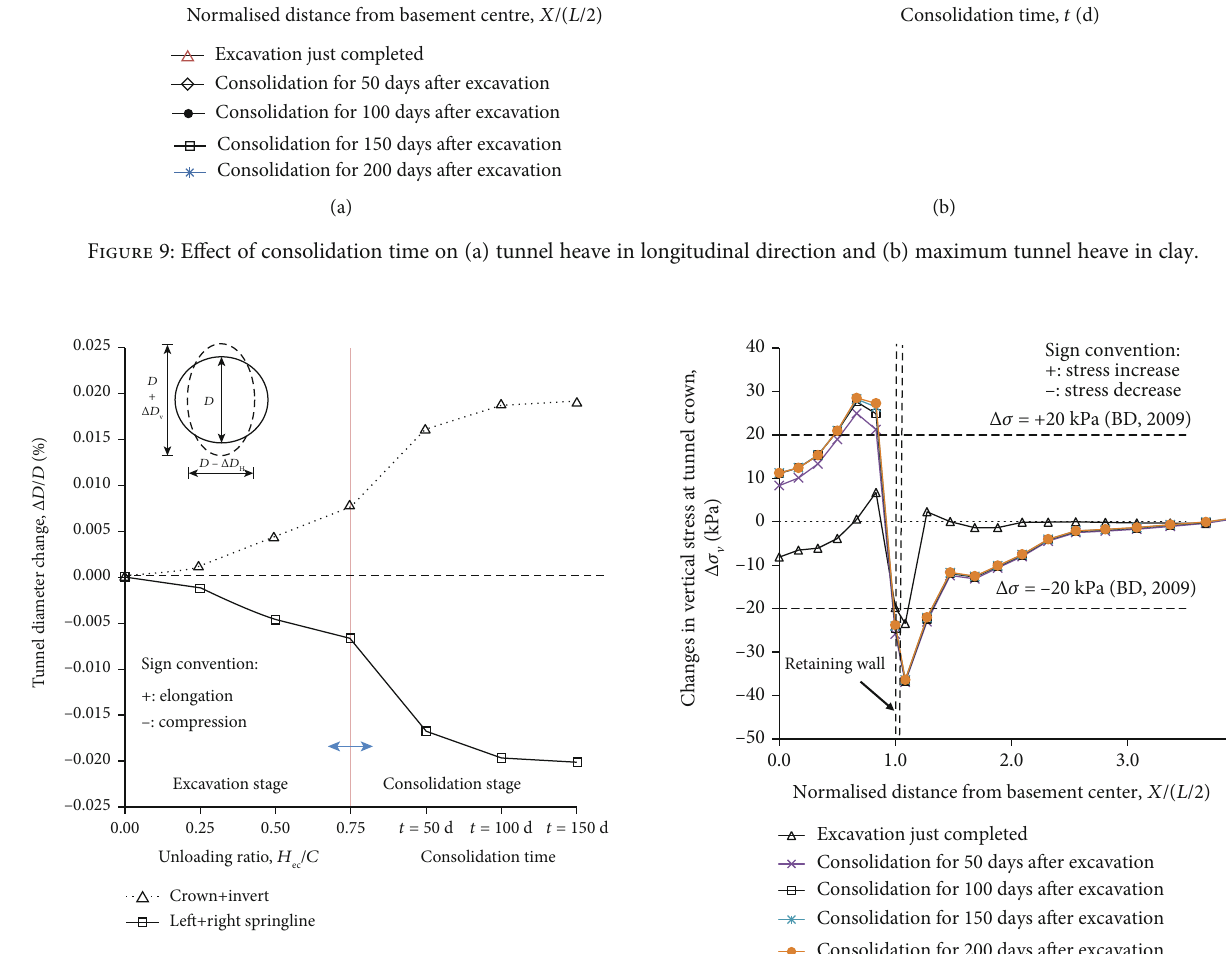
Figure 10: E ff ect of consolidation time on tunnel diameter change in clay. Figure 11: Soil vertical stress change at tunnel crown for di ff erent consolidation